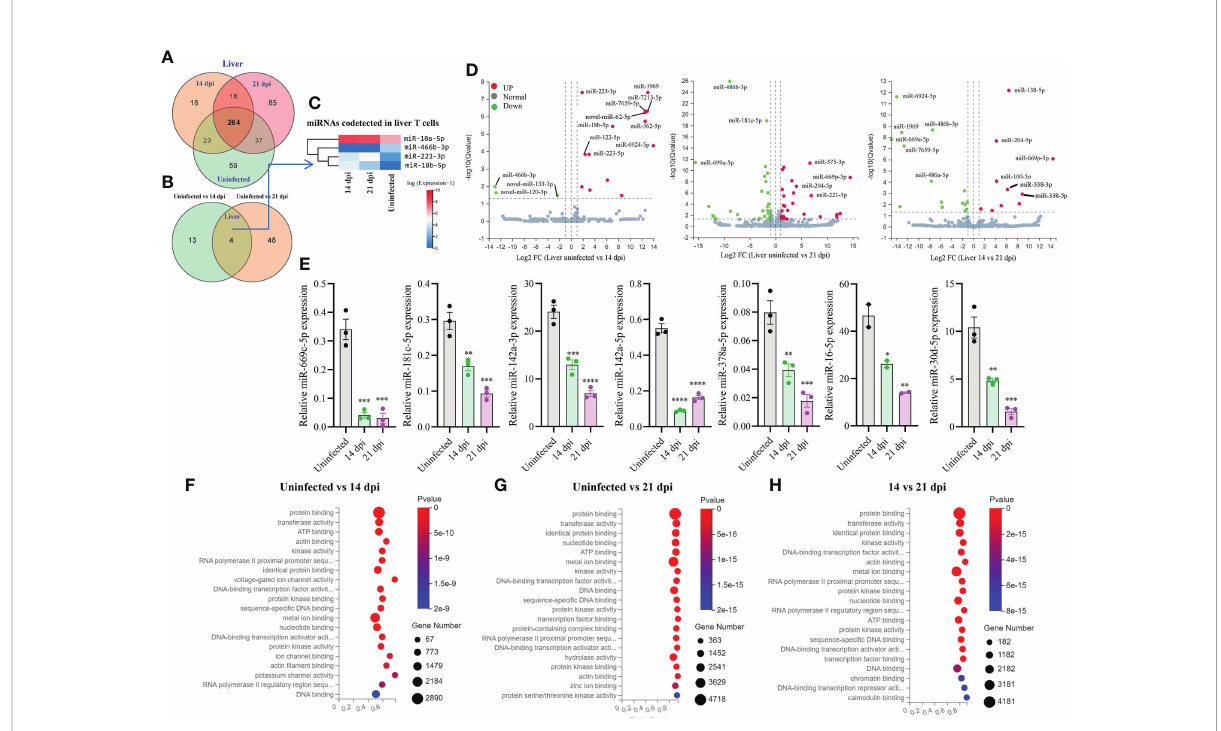
FIGURE 3 Liver T cell miRNAs pro fi les, validation of expressions, and prediction of molecular functions of their targets. (A) Venn diagram showing total and co-detected liver T cell miRNAs among uninfected, 14 dpi and 21 dpi groups (the number indicates the common or speci fi c miRNAs identi fi ed in different groups); (B) Venn diagram showing co-detected and speci fi c liver T cell miRNAs between two groups (uninfected vs 14 dpi and uninfected vs 21 dpi); (C) Heatmap showing the expression of differentially expressed liver T cell miRNAs co-detected between two groups (uninfected vs 14 dpi and uninfected vs 21 dpi); (D) Volcano plot showing differentially expressed liver T cell miRNAs for different comparative analyses (uninfected control vs 14 dpi; uninfected control vs 21 dpi; 14 dpi vs 21 dpi). Green dot indicates down regulated miRNAs, red dot indicates upregulated miRNAs and grey dot indicates no signi fi cantly expressed miRNAs; (E) Validation of selected increased and decreased expressions of liver T cell miRNAs by RT-qPCR. Data illustrate representative results and show the mean and standard error mean from an experiment carried out in triplicate. Statistical analysis was performed comparing uninfected vs 14 dpi or 21 dpi using one-way ANOVA and * denotes P ≤ 0.05, ** denotes P ≤ 0.01, *** denotes P ≤ 0.001, **** denotes P ≤ 0.0001; (F – H) GO enrichment analyses of molecular functions of targets for differently expressed miRNAs (Uninfected vs 14 dpi (F) ; Uninfected vs 21 dpi (G) ; 14 dpi vs 21 dpi (H) in liver T cells). The results showing 20 most signi fi cantly enrichment functions of targets for differentially expressed